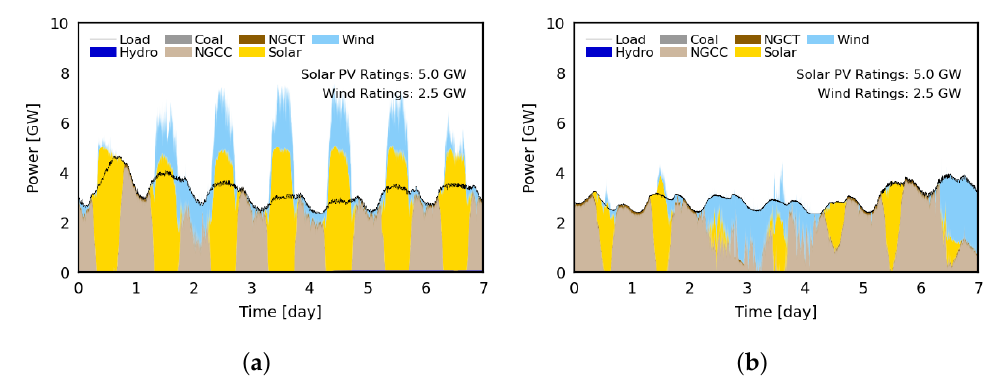
Figure 7. Example weeks of economic dispatch with a natural gas-dominated scenario for ( a ) a high renewable capacity factor week from May 8–14 and ( b ) low renewable capacity factor week from January 8–14. Utilization of natural gas-dominant generation allows for greater renewable potential due to faster ramping